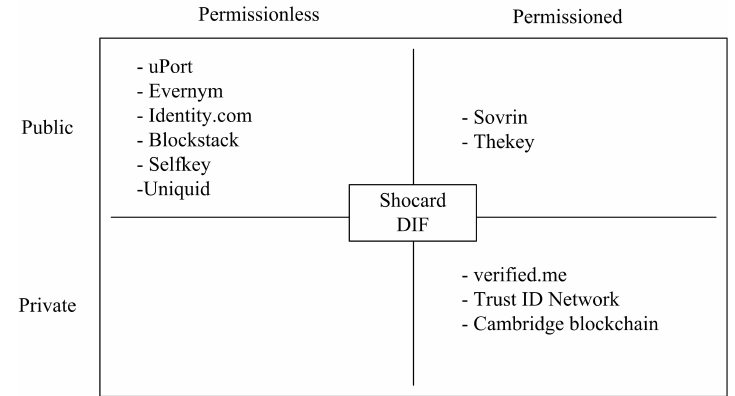
Figure 2. Identity solutions-based distributed ledger technology (DLT)